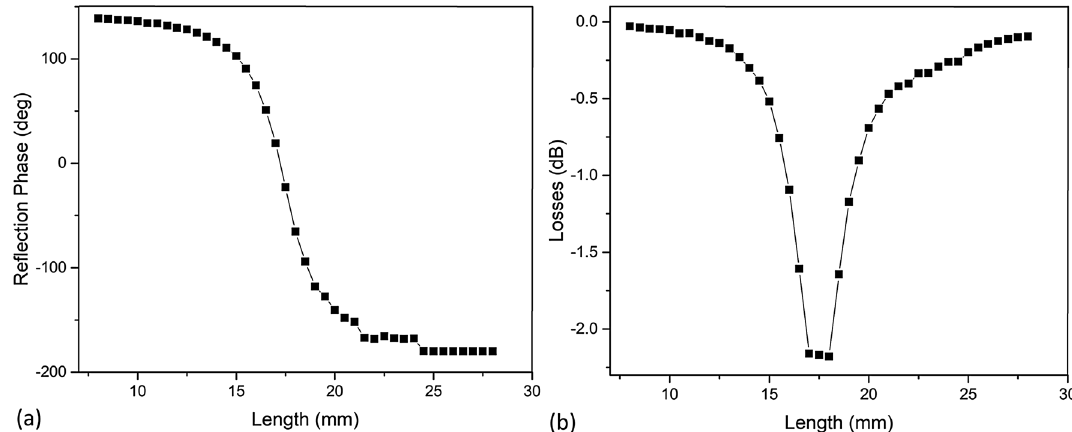
Figure 6. Reflection phase curve ( a ) and loss curve ( b ) of the simulated mid-band hybrid structure for 5